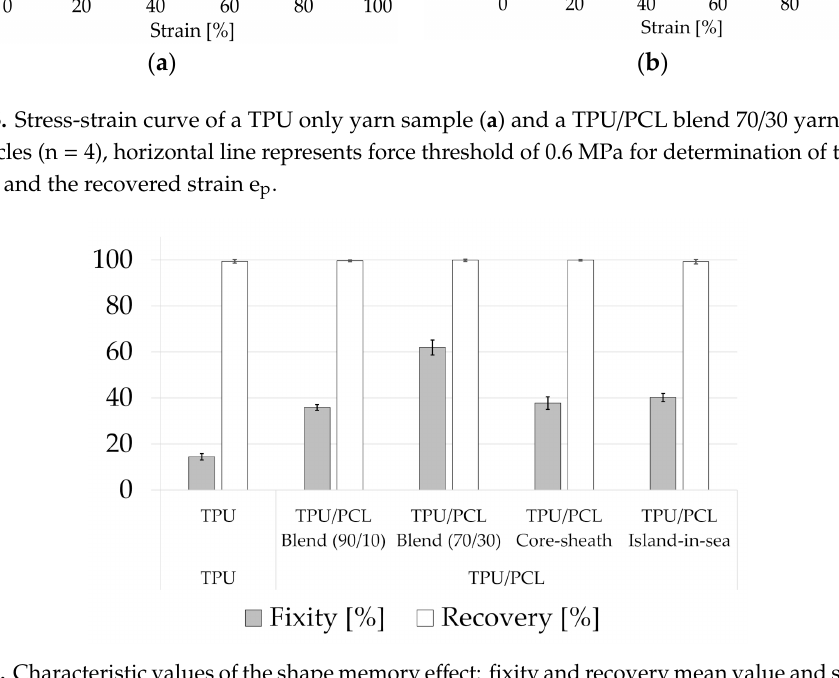
Figure 6. Characteristic values of the shape memory e ff ect: fixity and recovery mean value and standard deviation, sample size =